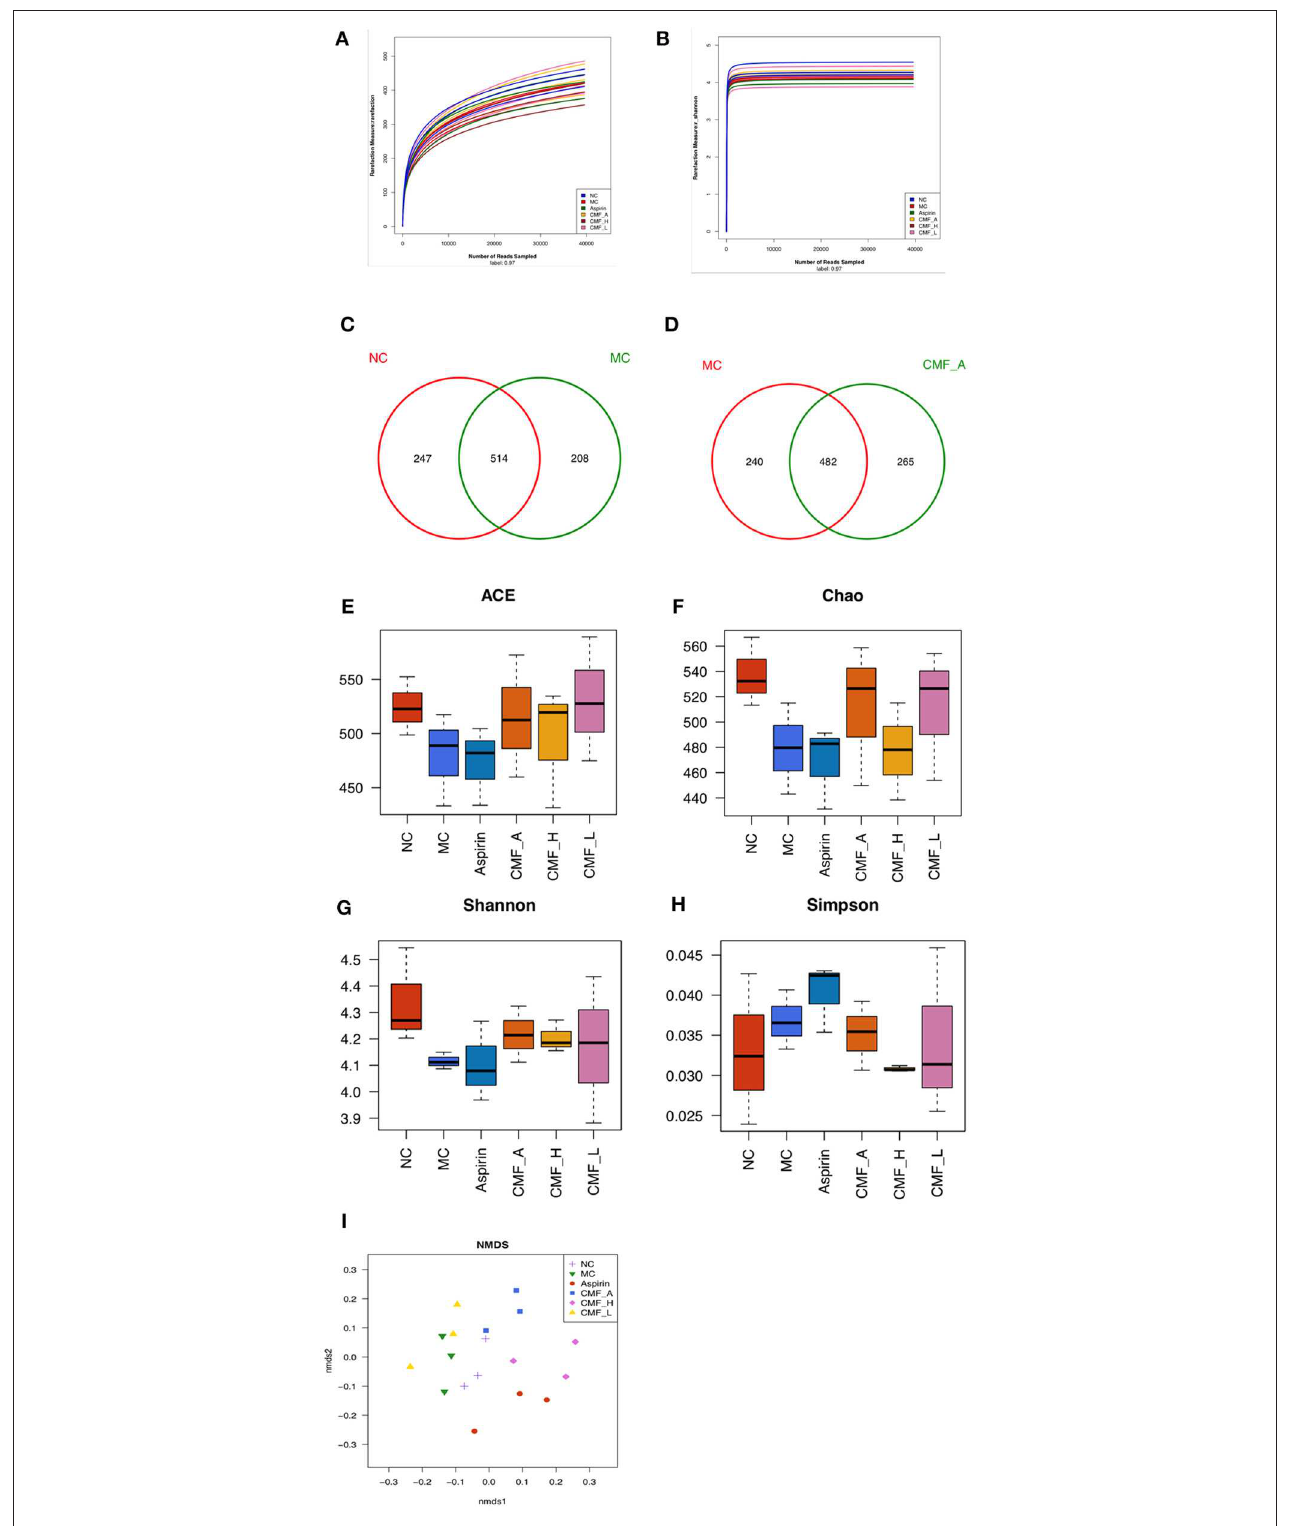
FIGURE 4 | Illumina Miseq sequencing data showed CMF modulates the overall component of gut microbiota. (A) Rarefaction curves determined at the 97% similarity level. (B) Shannon-Wiener curves of samples, calculated using mothur. (C–F) Venn diagram of OUTs in the different groups. (G–I) Community richness and diversity index of the model control group (MC), normal control group (NC), aspirin group, and CMF intervention groups (CMF-A/H/L) on ACE, Chao, Shannon, Simpson analysis.